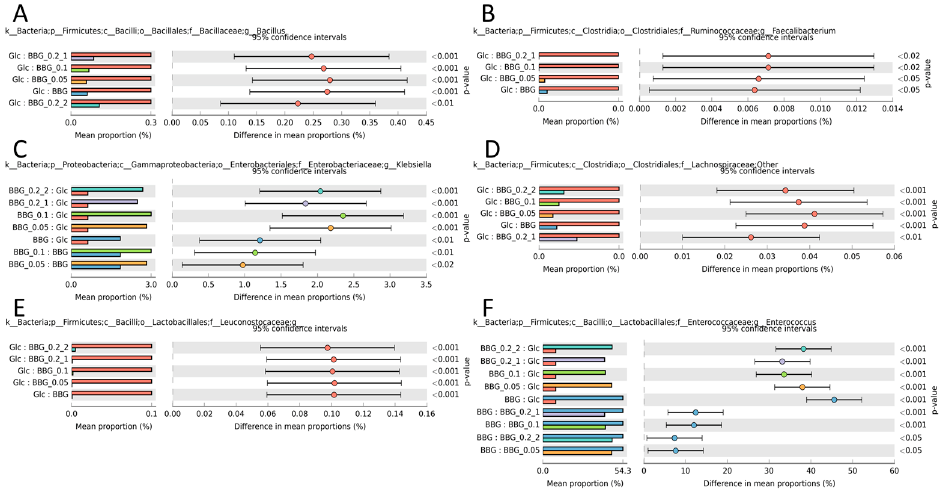
Figure 7. Significantly different taxa in genus level identified using ANOVA (Tukey HSD post-hoc test) with Benjamini-Hochberg FDR multiple test correction. ( A ) Bacillus ; ( B ) Faecalibacterium ; ( C ) Klensiella ; ( D ) Lachnospiraceae ; ( E ) Leuconostocaceae ; and ( F ) Enterococcus . These taxa were considered either neutral or opportunistic pathogenic to the hosts.